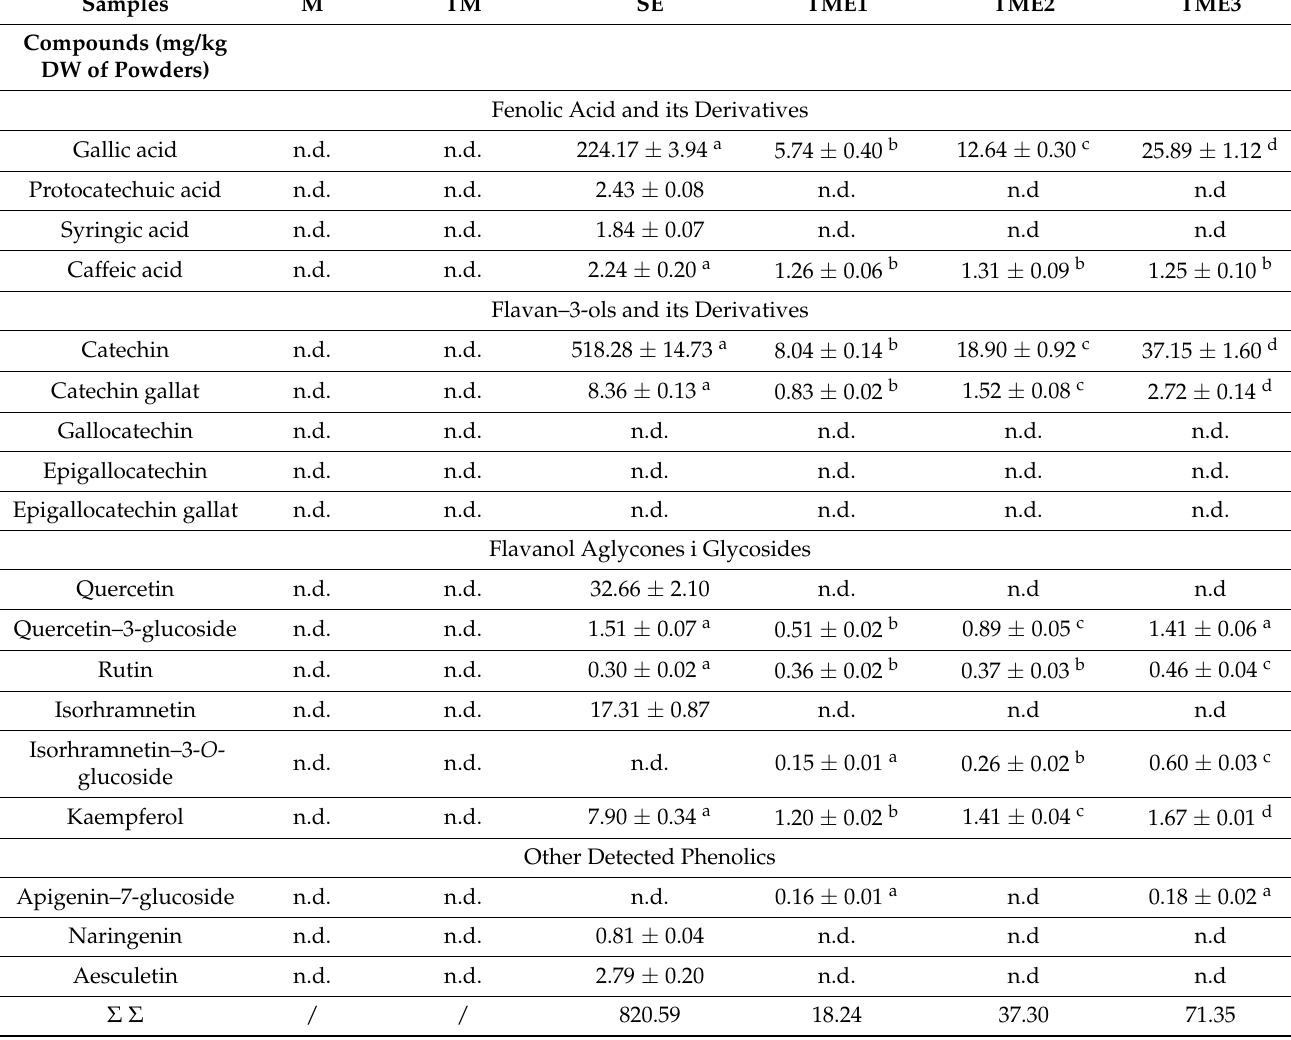
Table 2. The content of phenolic compounds in methanolic extracts of M, TM, SE and TME powders (results are expressed as mg/kg SM of powders), determined using UHPLC-DAD